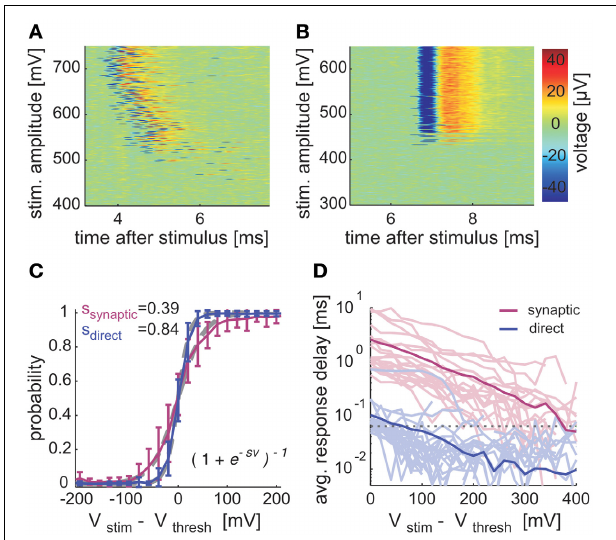
FIGURE 2 | Input-output and latency in synaptically and directly evoked spikes. Voltage traces of synaptic (A) and direct (B) responses sorted by stimulation amplitude. Stimulation amplitudes were delivered (at 0.25Hz) in 600 steps between 200 and 800mV in randomized order (zoom into dynamic range). (C) Averaged I/O relations, aligned to threshold stimulation amplitude. Logistic functions (gray dashed lines) were fitted to the averaged data. (D) Deviation of response latencies from threshold to V 100% , plotted on a semi-logarithmic scale. Bold lines indicate population mean values; dashed line marks the temporal resolution of the recording setup. In (C,D) , networks ( n = 12, 49 different neurons) were stimulated ( ≤ 0.333Hz) with randomized amplitudes between 200 and 800mV; fast synaptic transmission was blocked subsequently with ≥ 10 μ M CNQX. Blocked and unblocked responses were accordingly classified as synaptic mediated ( n = 21) and directly evoked ( n = 28) responses. Electrodes, recording responses that could be clearly attributed to a single neuron by spike shape and amplitude and spanned the full response range (from 0 to 1 probability) in the applied stimulation amplitudes, were used. Responses with spike delays beyond 20ms latency at 800mV were